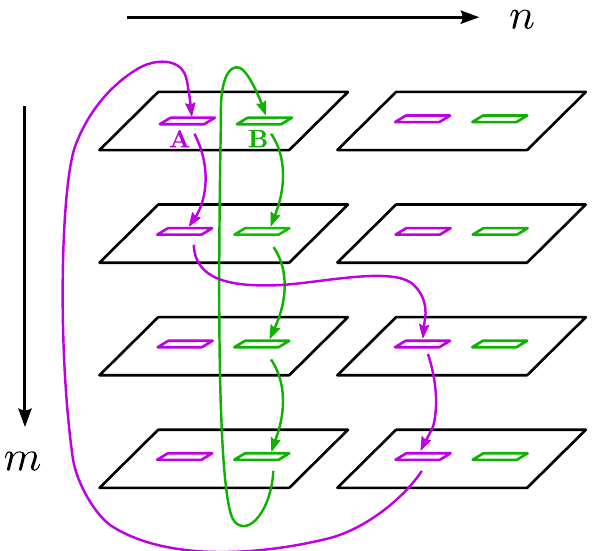
Fig. 1 Structure of the replica manifold for the Rényi reflected entropy between subsystems A and B in the state | ψ m (cid:4) . The sewing of the indi- vidual replicas along the subsystems A and B are denoted by magenta and green arrows corresponding to the twist fields σ g tively. Figure modified from